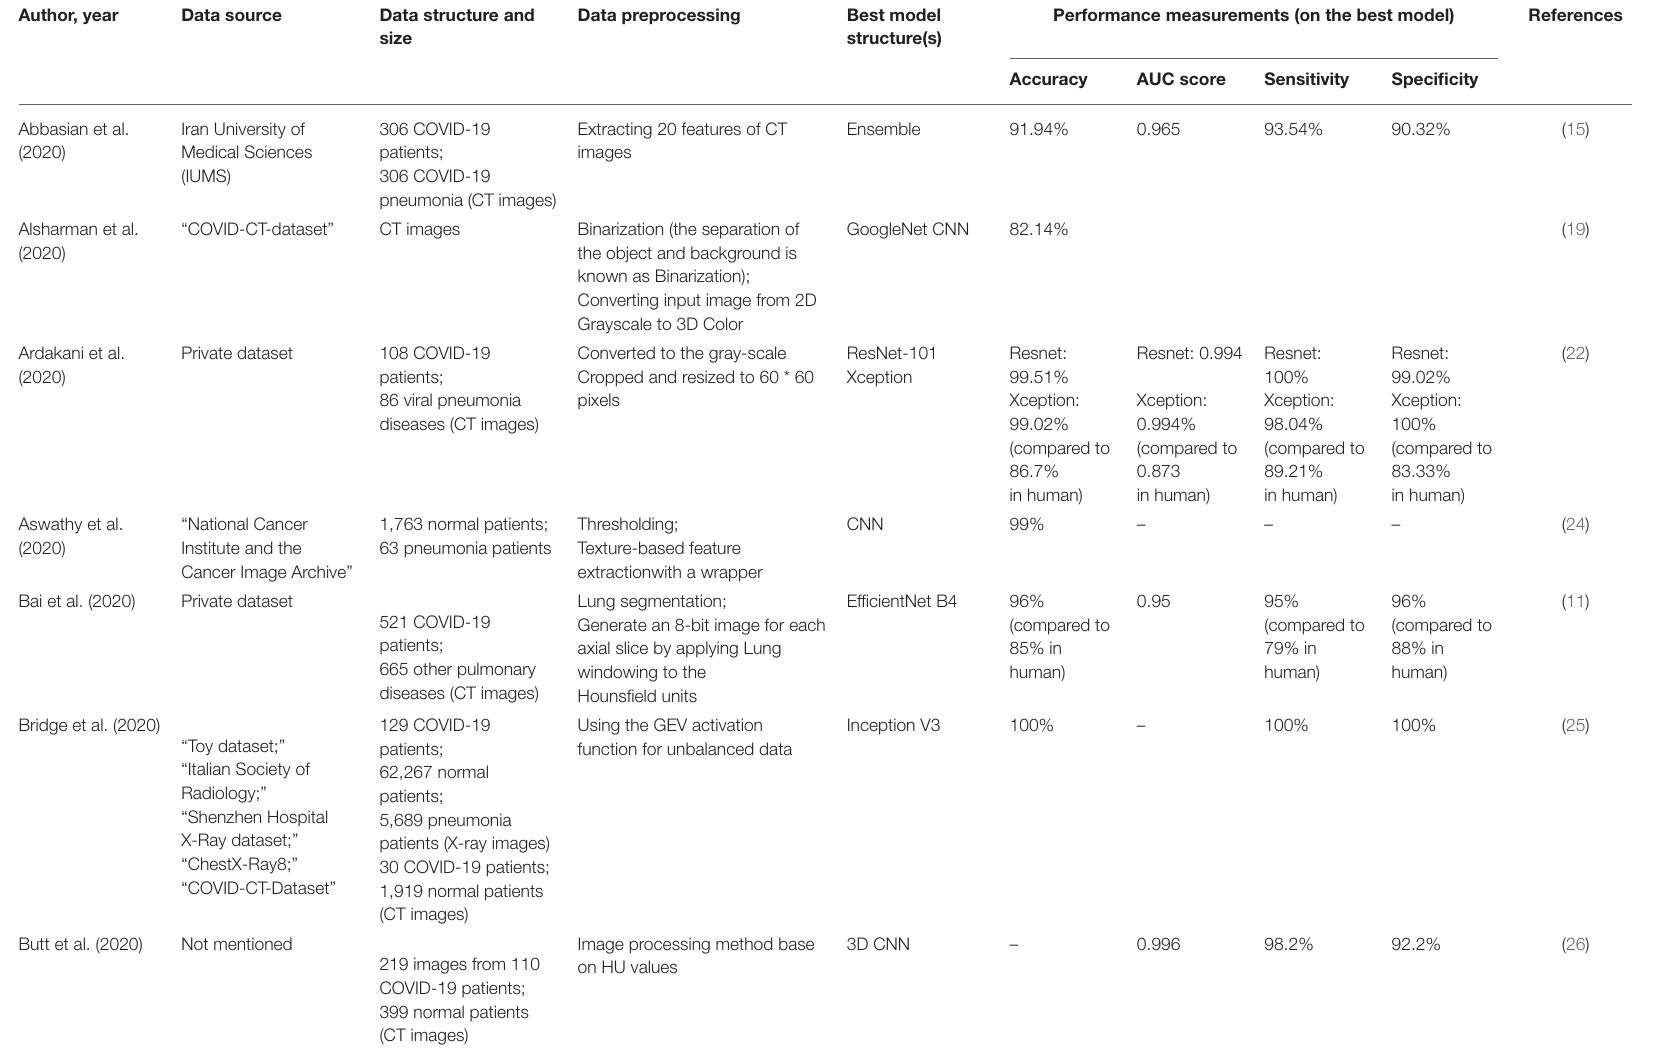
TABLE 1 | Characteristics of papers that used CT images or a combination of X-ray and CT